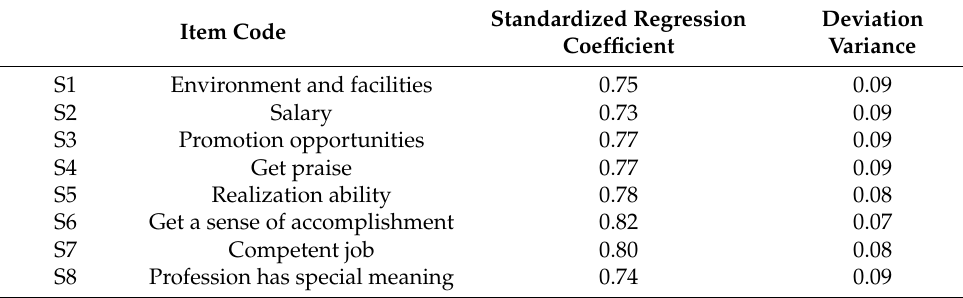
Table 3. Job Satisfaction scale offending estimate check